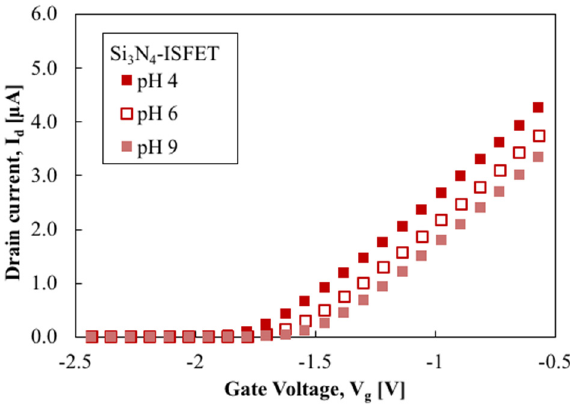
Figure 7. I d –V g of Si 3 N 4 -gate ISFET in various pH solutions.